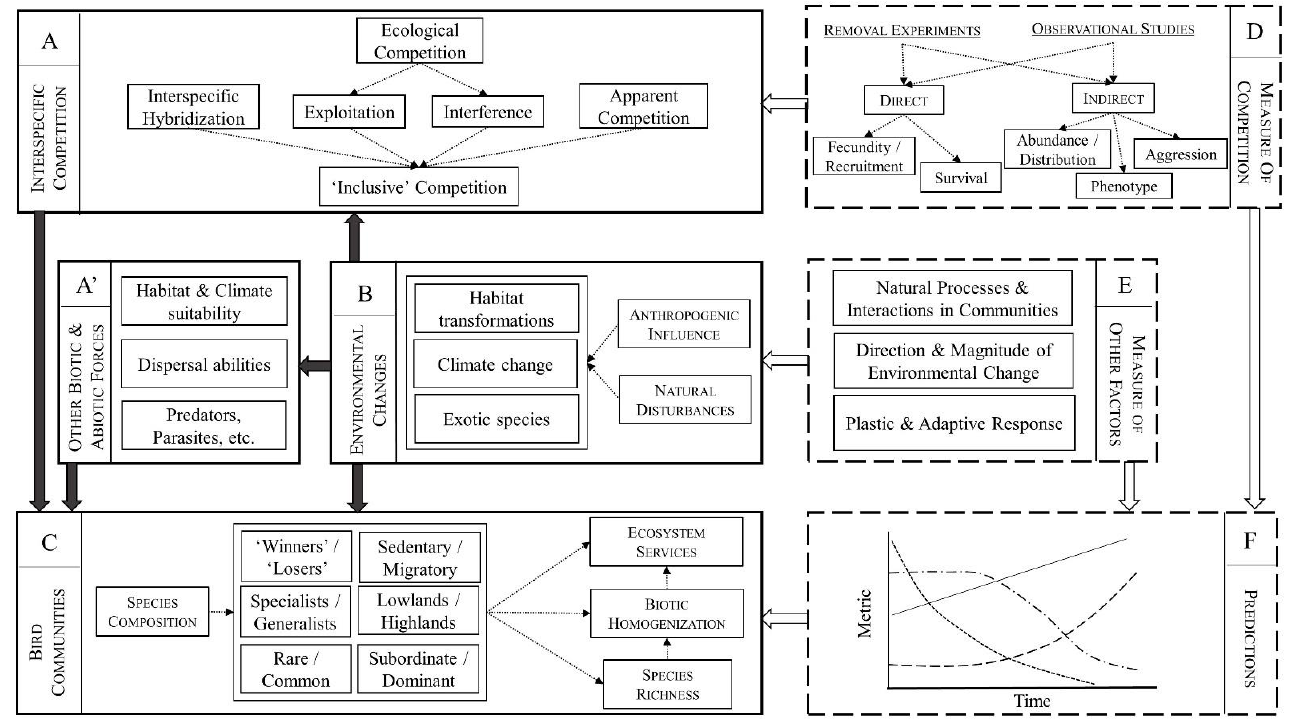
Figure 1. Synthesis. Environmental changes (panel B ) affect bird communities directly, through habitat transformation, climate change, and the introduction of exotic species, as well as indirectly, through a modification of dispersal abilities ( A’ ) and biotic interactions such as competitive interactions ( A + A ’ ). Interspecific competition may thus modulate species response to environmental changes and affect community-level responses including species composition, species richness, and ecosystem services ( C ). However, predicting the consequences of environmental changes ( F ) is hampered by multiple sources of uncertainty (indicated by dashed boxes) concerning the relative importance of interspecific competition and other forces ( D , E ). Causal relationships are indicated by black arrows; measures and predictions are indicated by white arrows See text for details.